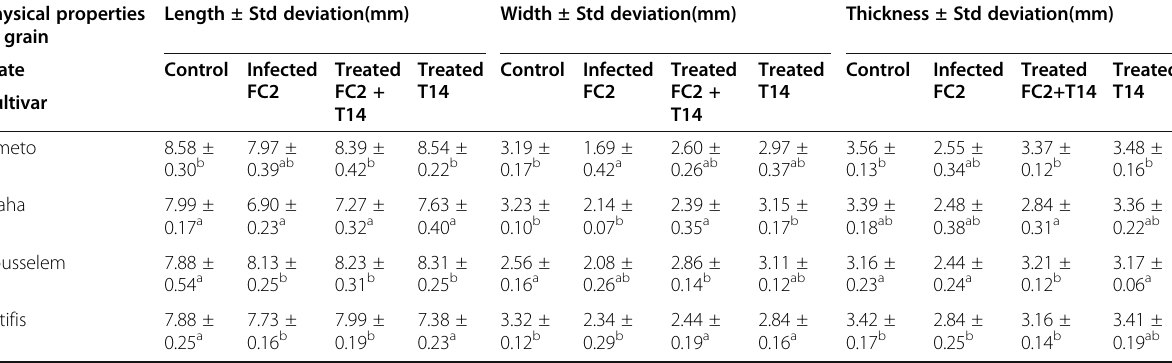
Table 5 Comparison of physical properties (length, width, thickness) of the grains of the 4 cultivars tested (control, FC2 infected, FC2 infected and treated with T14, and treated with T14 only) Physical properties of